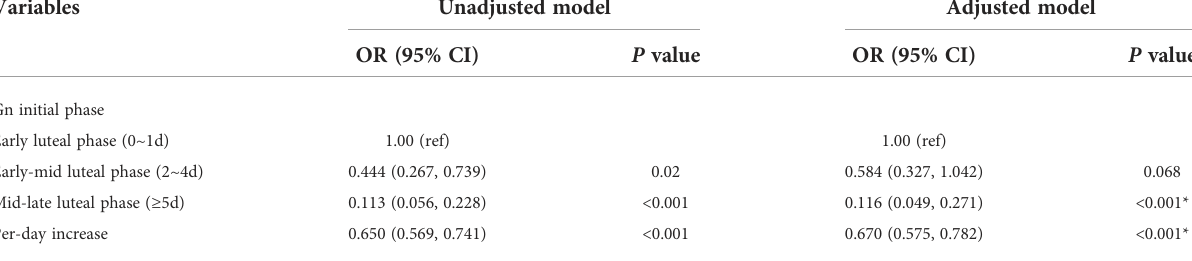
TABLE 2 Association between day of gonadotropin start and the shorter duration of ovarian stimulation ( ≤ 9 days) in patients with luteal phase stimulation.